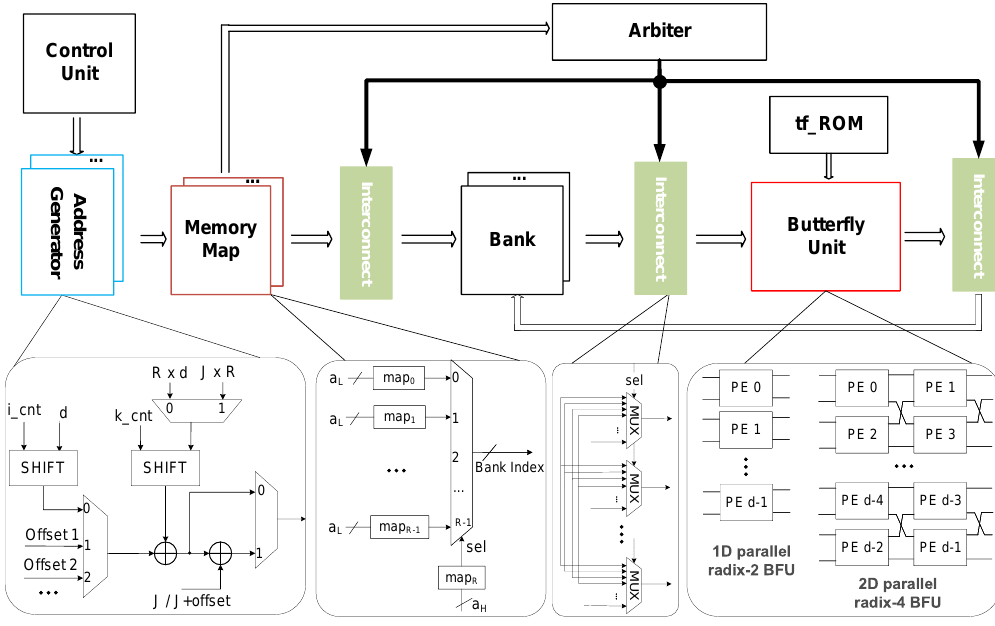
Figure 8: The scalable radix-2/4 NTT multiplication